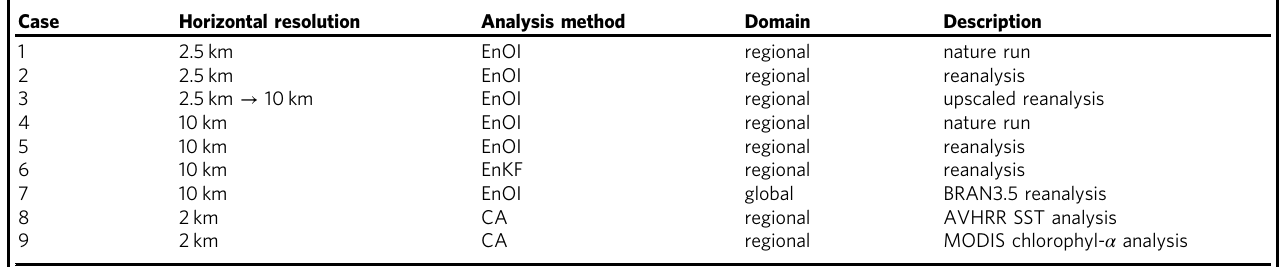
EnOI Ensemble Optimal Interpolation, EnKF Ensemble Kalman Filter, CA composite analysis, BRAN3.5 Bluelink Reanalysisversion 3.5, AVHRR advanced very-high resolution radiometer, SST sea surface temperature, MODIS moderate resolution imaging spectroradiometer